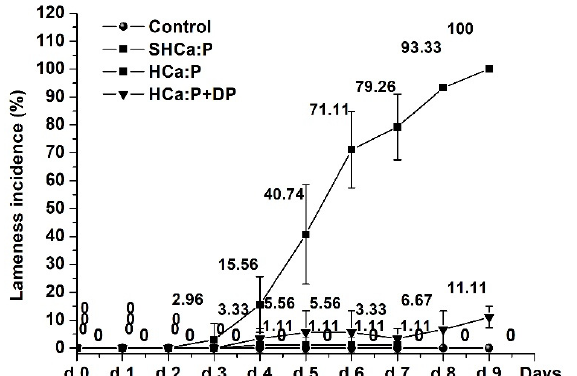
Figure 3. Lameness incidence in broiler chicks caused by high-calcium (Ca): phosphorus (P) ratio and P-deficient crumbled feeds in trials one to three (C). Control, Ca and P-balanced feed which did not cause chick lameness (n = 9 at days 0 to 7; n = 3 at days 8 and 9); HCa:P, high Ca:P ratio, P-deficient crumbled feed from farms with severe chick lameness issues (n = 9). SHCa:P, slightly high Ca:P ratio, P-deficient crumbled feed from farms with slight chick lameness issues (n = 6); HCa:P + DP, feed made by mixing 1.5% dicalcium phosphate (DP) powder into HCa:P crumbled feed (n = 6 at days 0 to 7; n = 3 at days 8 and 9). Lameness incidence is calculated from mixed data in trials one to three and given as mean ±